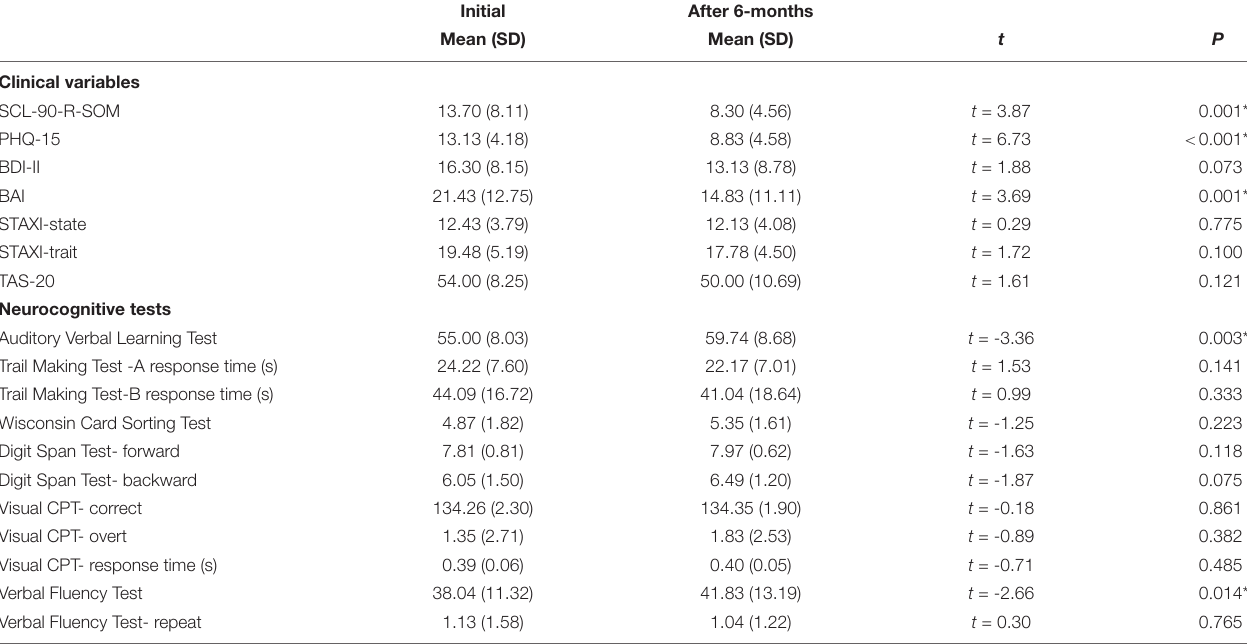
TABLE 2 | The change of psychological and neurocognitive variables after 6 months in patients with SSD ( N = 23). Initial After 6-months Mean (SD) Mean